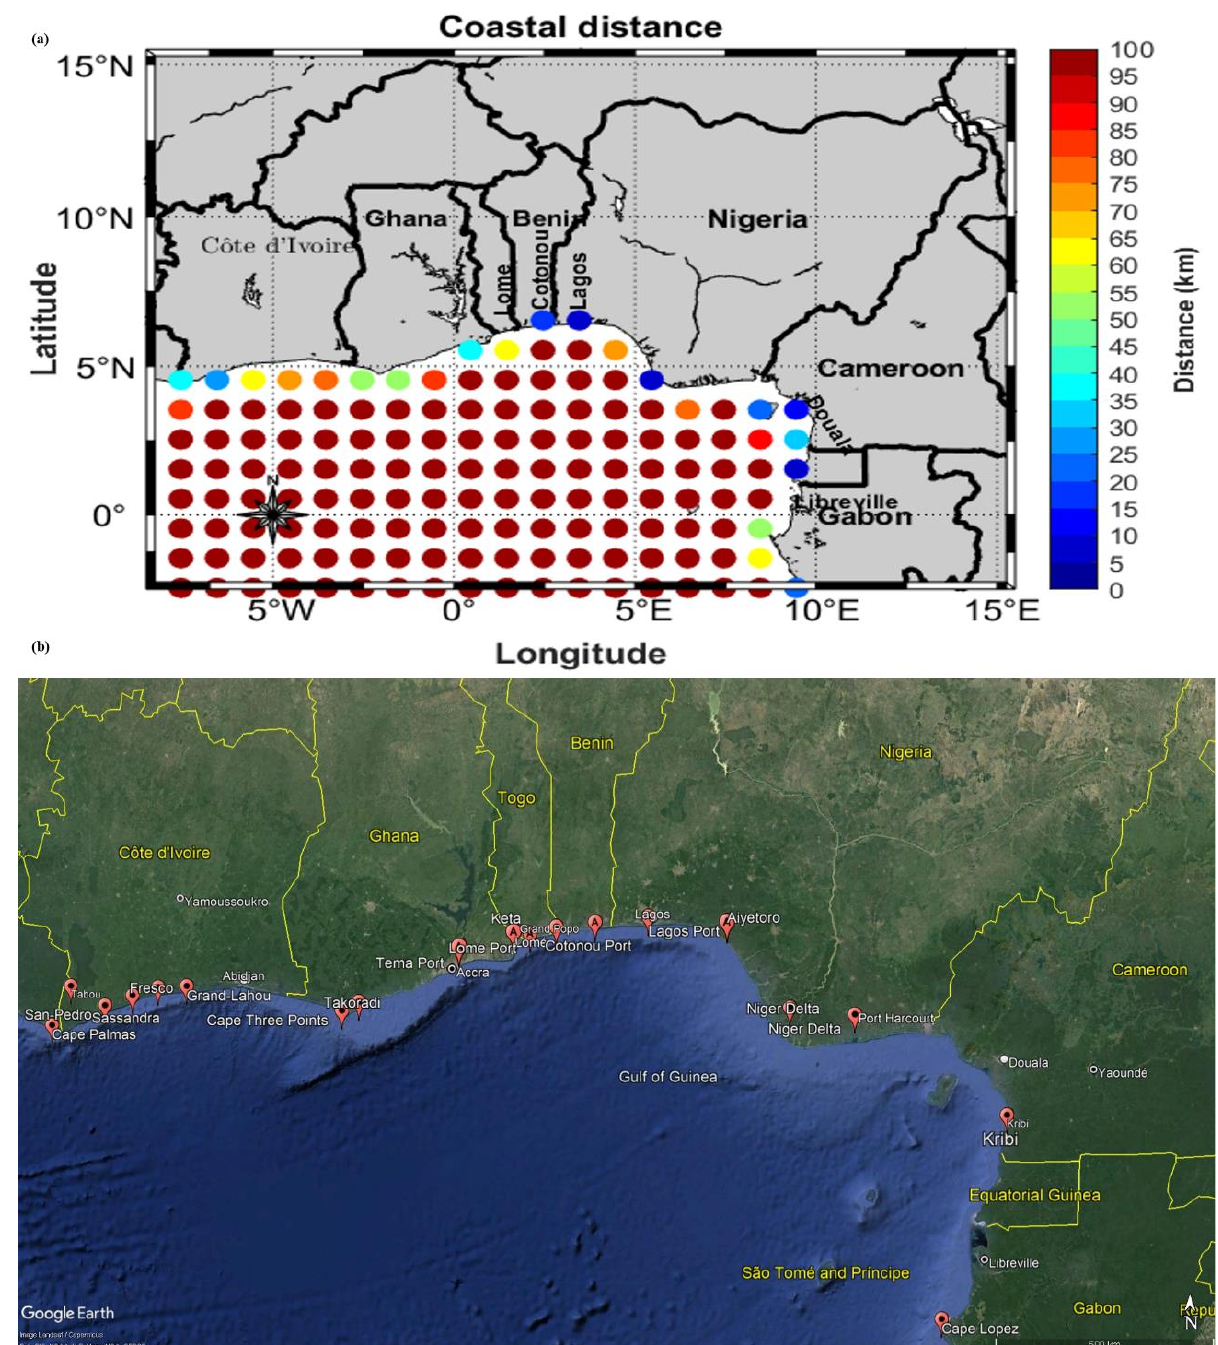
Figure 14. ( a ) Distance of each grid point to the nearest coastline in the GoG. ( b ) Map oof the GoG with some notable coastal structures on the continental shelf (light blue areas close to the coast).